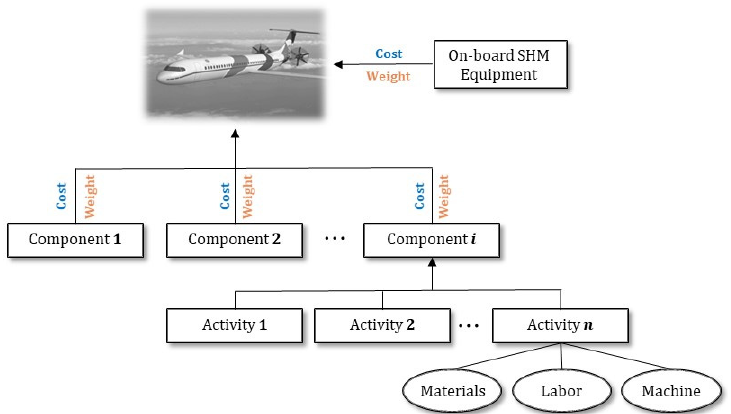
Figure 2. Bottom-up model for the estimation of the total costs and added weight in the complete structure.